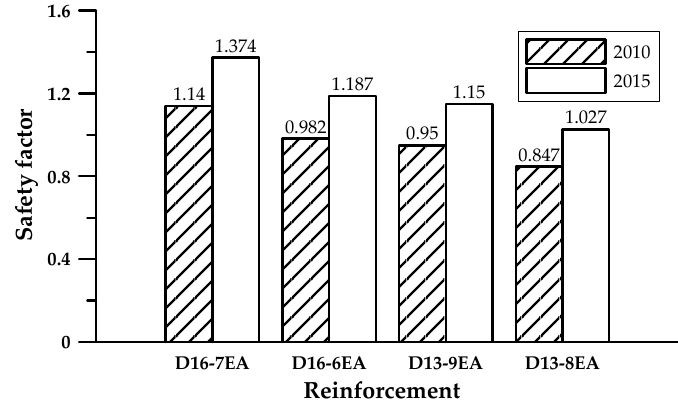
Figure 7. Changes in the safety factor based on the amount of reinforcement.